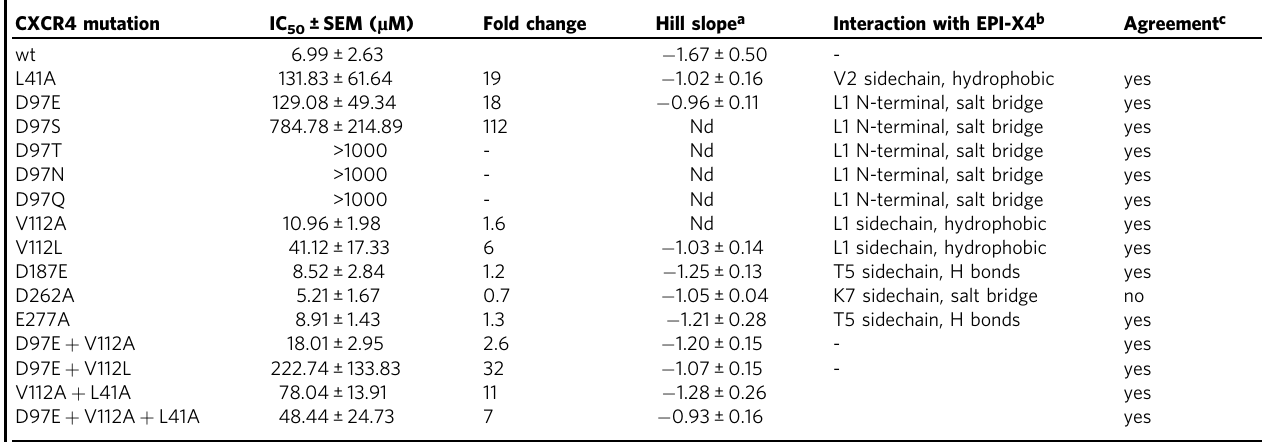
Table 1 IC 50 values of EPI-X4 determined in a 12G5-competition assay for CXCR4 mutants. CXCR4 mutation IC 50 ± SEM ( µ M) Fold change Hill slope